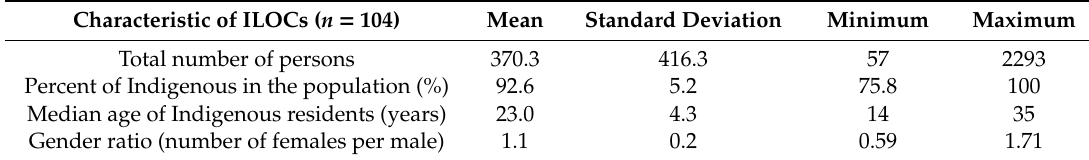
Table 1. Descriptive characteristics of Indigenous locations (ILOCs).